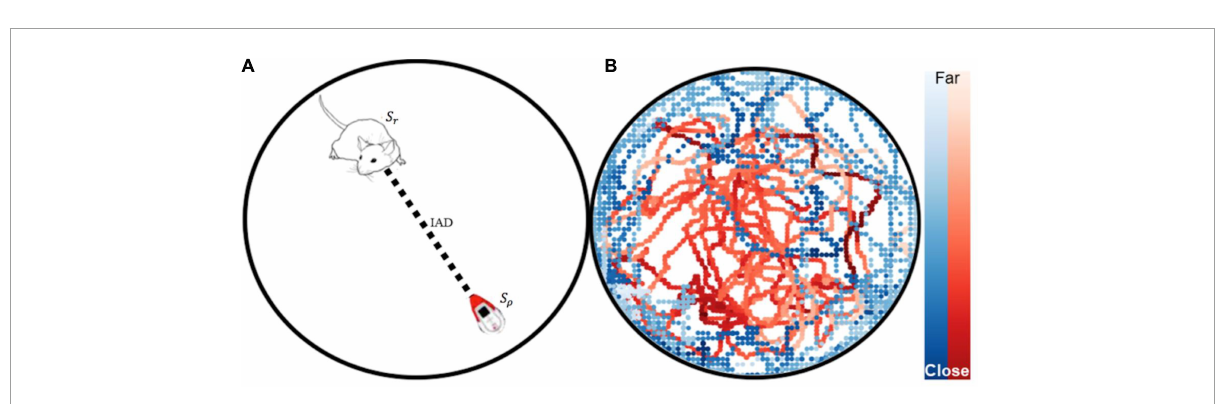
FIGURE4 (A) Animal and robot position tracking with SLEAP. Automated tracking-based behavior segmentation with state vectors S r and S ρ , and the inter-agent distance (IAD). (B) Tracking data from a robot free roam trial is plotted.